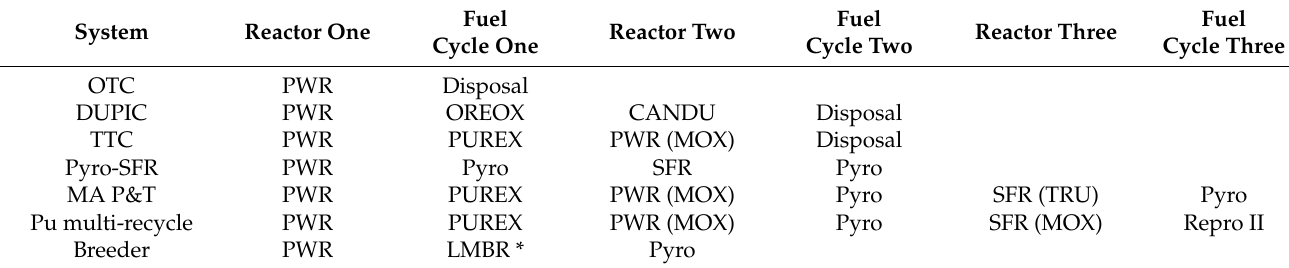
Table 4. Fuel cycle variants modelled by Gao and Ko